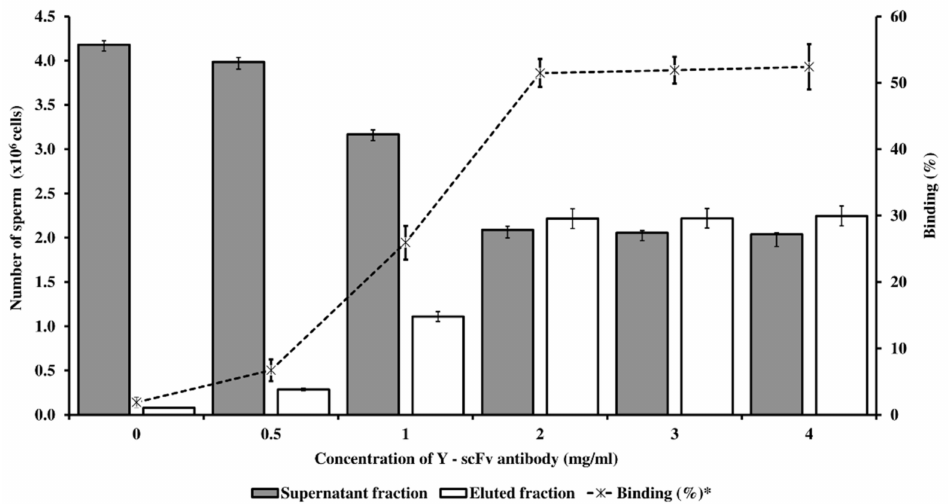
Figure 4. The concentration of Y-scFv antibody coupled to PLA-M microbeads bound with conven- tional bovine sperm with an X/Y-sperm ratio of 1:1 (expressed in the bar graph) and percentage of binding capacity (expressed in the linear graph) in fresh semen. * % Binding = (Eluted fraction sperm/total sperm) ×